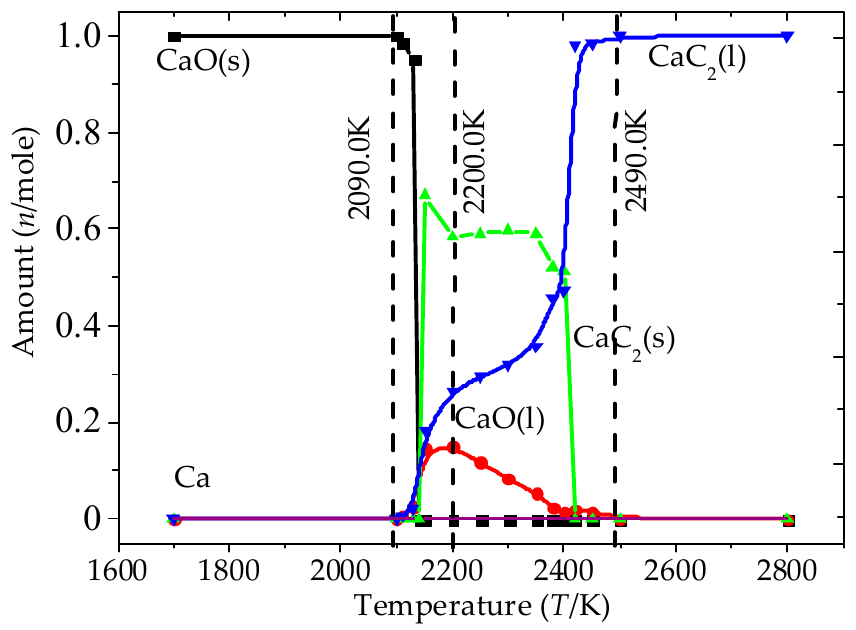
Figure 13. The equilibrium composition at each reaction temperature. ChemEngineering 2020 , 4 , x FOR PEER REVIEW